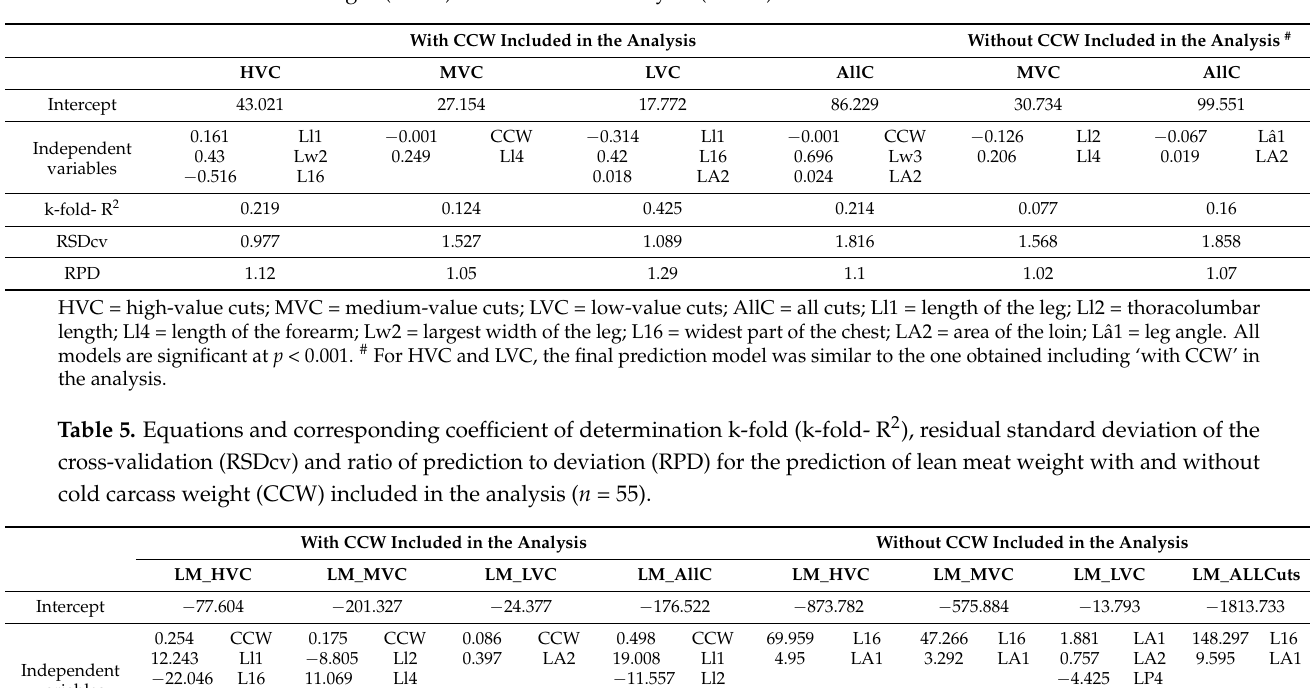
Table 4. Equations and corresponding coefficient of determination k-fold (k-fold- R 2 ), residual standard deviation of the cross-validation (RSDcv) and ratio of prediction to deviation (RPD) for the prediction of cut percentage of the carcass with and without cold carcass weight (CCW) included in the analysis ( n = 55).